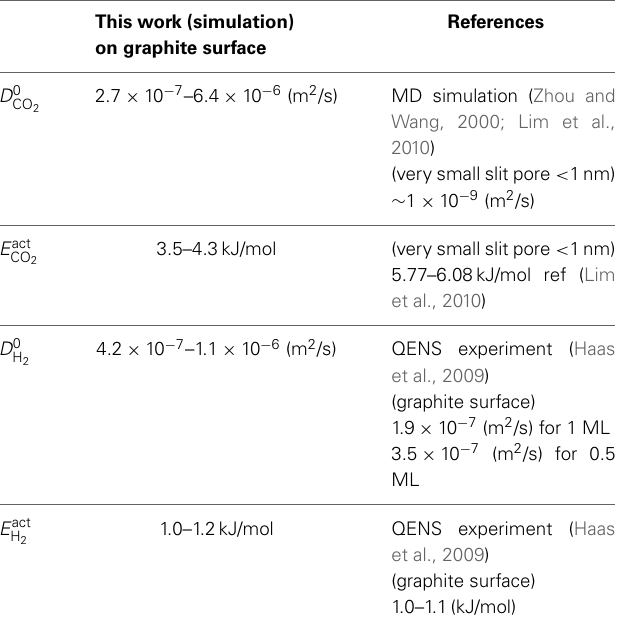
Table 3 | Summary of results on self-diffusion parameters cf. Equation (17) for a mixture of CO 2 and H 2 on a graphite